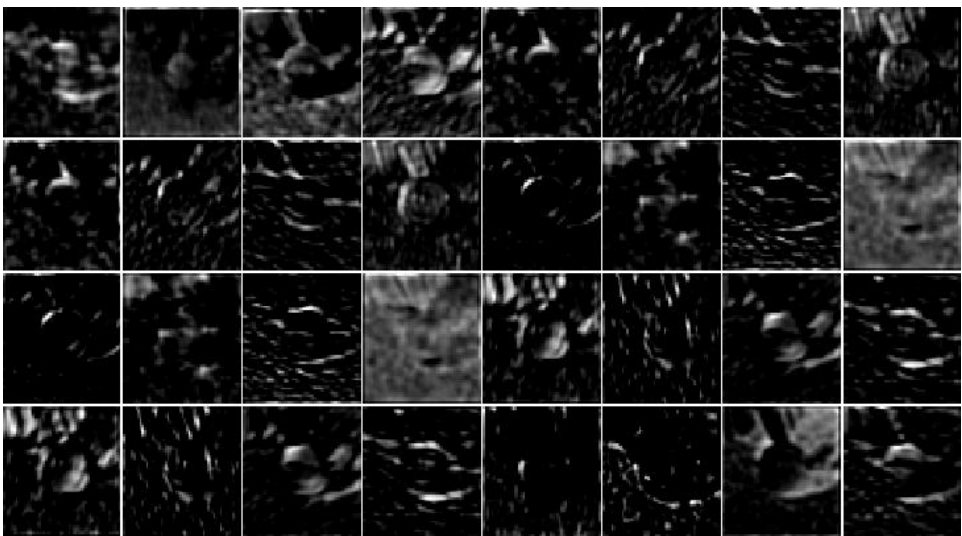
Figure 3. The first 32 channels of deep features from conv 3-4.